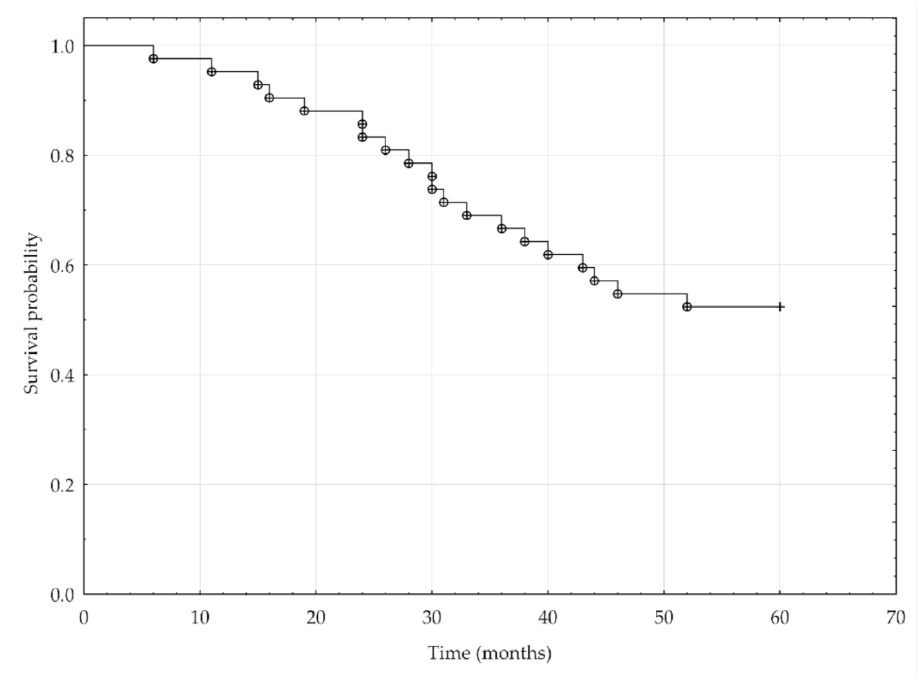
Figure 3. Kaplan–Meier analysis of the 5-year overall survival for 42 RMS